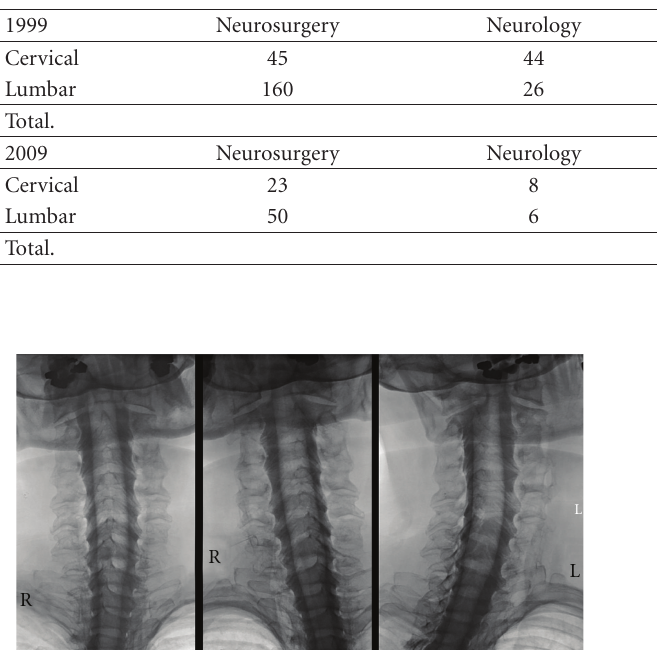
Table 2: Myelographies in the authors’ institution by region and referring department: comparison between 1999 and 2009.